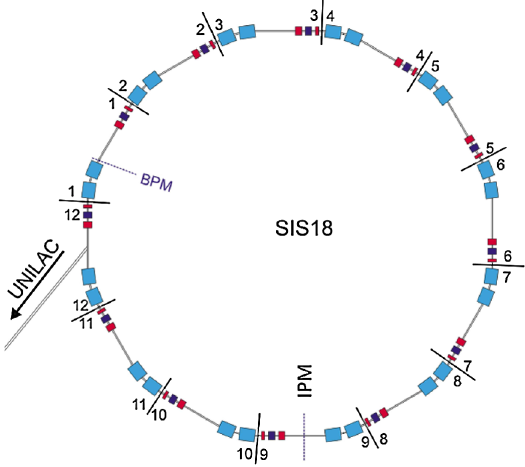
FIG. 3. Horizontal (a) and vertical (b) beam profile measure- ment for the SIS18 tunes Q x ¼ 4 : 340 , Q y ¼ 3 : 245